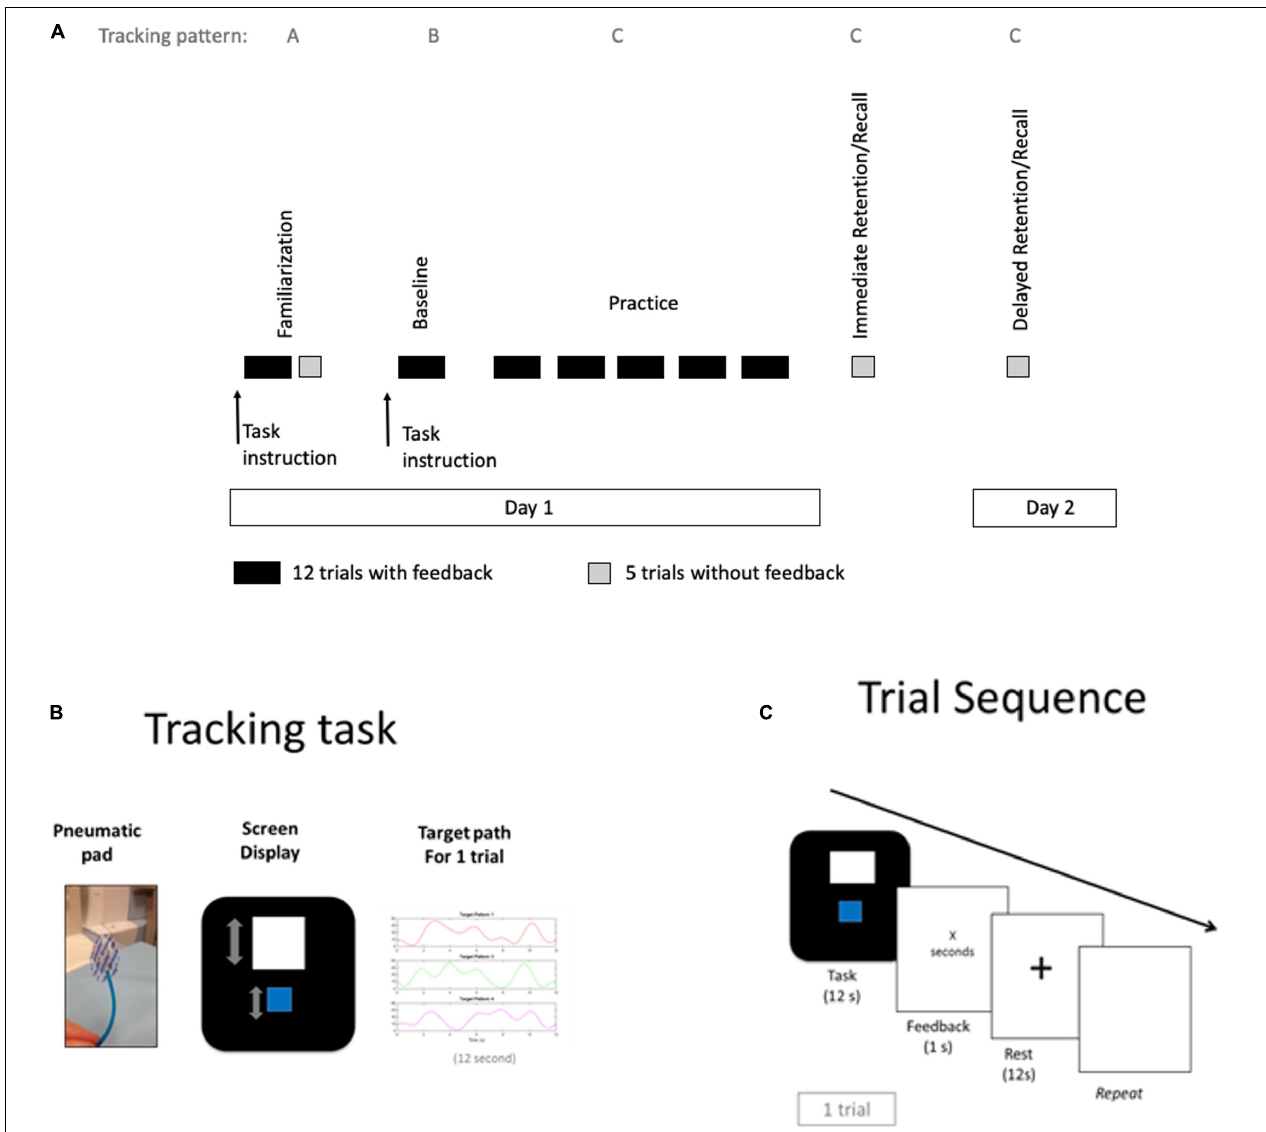
FIGURE 1 | Study procedures, tracking task and trial sequence. (A) Study procedures started with Familiarization session in the mock scanner including trials with time on target feedback (dark rectangles) and test trials without feedback (gray squares), followed by a baseline block in the MRI scanner and 5 practice blocks. A test block was given in the scanner 5 min after end of practice (immediate retention). A second test block occurred 1 day later inside the mock scanner (Delayed retention). Three different spatiotemporal tracking patterns were used across time points (familiarization period: pattern A, baseline period: pattern B, and practice period: pattern C). (B) The tracking task involved applying force with thumb and index finger to a pneumatic pad that controlled the vertical movements of a blue cursor on the screen that displayed the moving white target, changing vertical position according to the 3 different patterns. (C) The sequence for each trial displayed 12 s of the task period, followed by a 1 s presentation of time on target feedback, which was followed by a 12 s rest